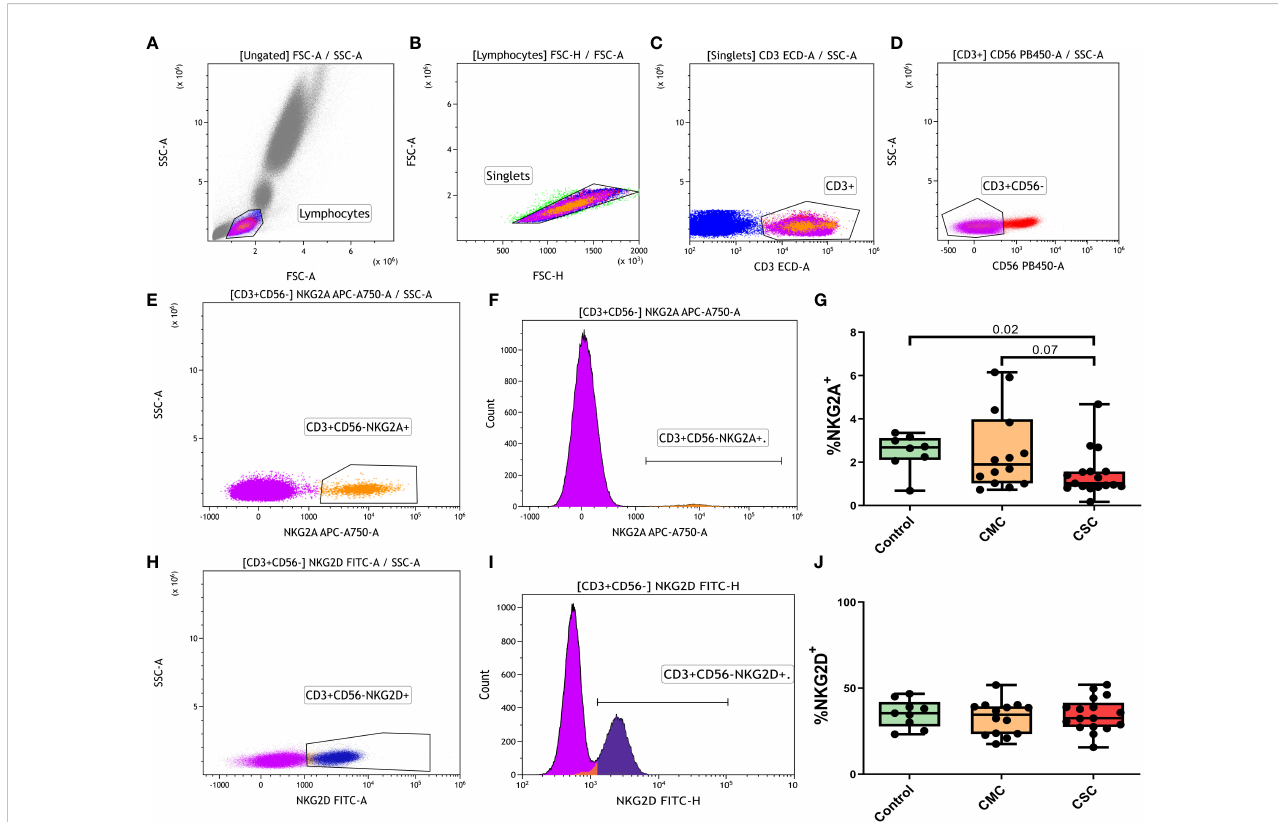
FIGURE 4 Percentage of NKG2A + and NKG2D + cells in the CD3 + CD56 - T population. (A-D) Gating strategy for the selection of the CD3 + CD56 - T population: (A) Gating of lymphocytes by forward and side scatter. (B) Selection of single events. (C) Selection of CD3 + events. (D) Selection of the CD3 + CD56 - events in the CD3 + lymphocyte gate. (E, F) Selection of the NKG2A + CD3 + CD56 - T cells by dot plot (E) and histogram plot (F) . (G) Differences in the percentage of NKG2A + CD3 + CD56 - T cells in controls, CMC and CSC participants. (H, I) Selection of the NKG2D + CD3 + CD56 - T cells by dot plot (H) and histogram plot (I) . (J) Differences in the percentage of NKG2D + CD3 + CD56 - T cells in controls, CMC and CSC participants. CMC/CSC: convalescent of mild/severe COVID-19 individuals. Boxes represent the 25 and 75% quartiles, lines represent the median of the distribution, and whiskers are the maximum and minimum values of the